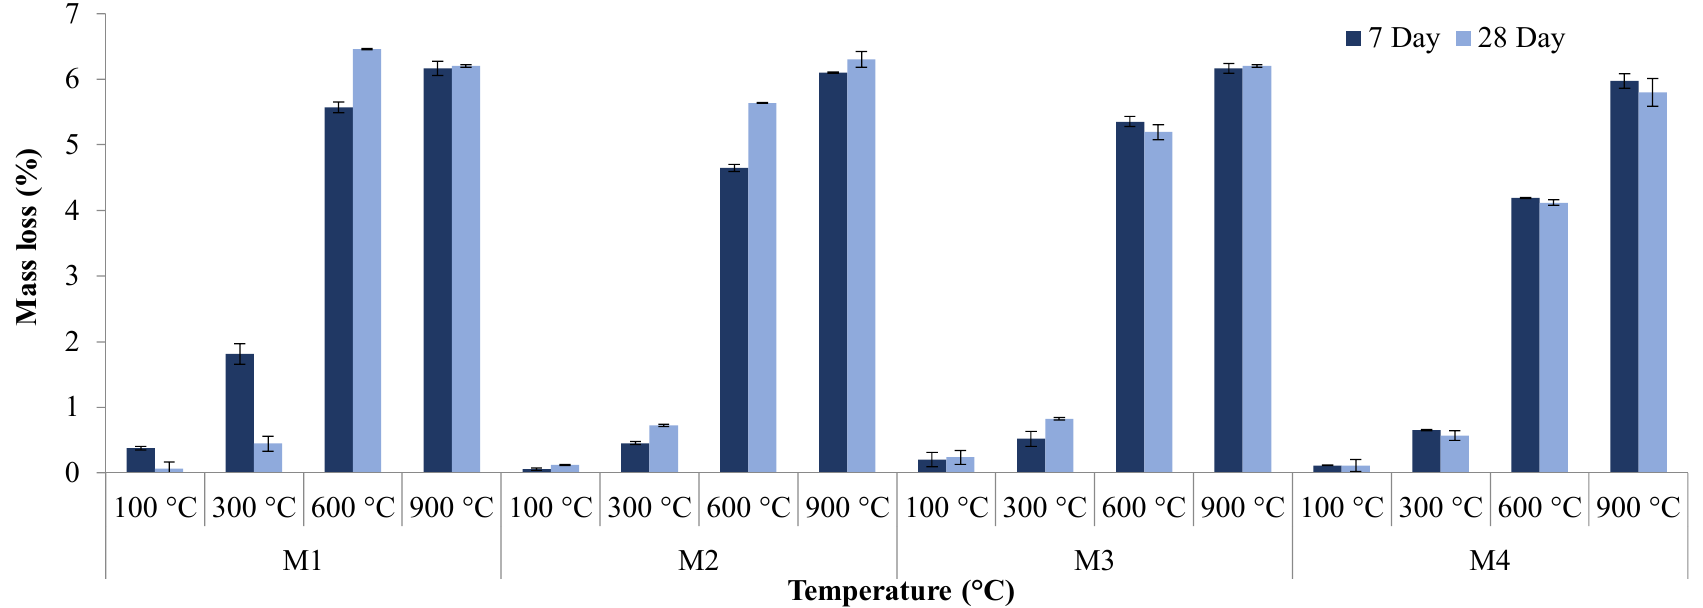
Figure 12. Mass loss versus temperature. Table 9. Mass loss (percentage) by temperature.